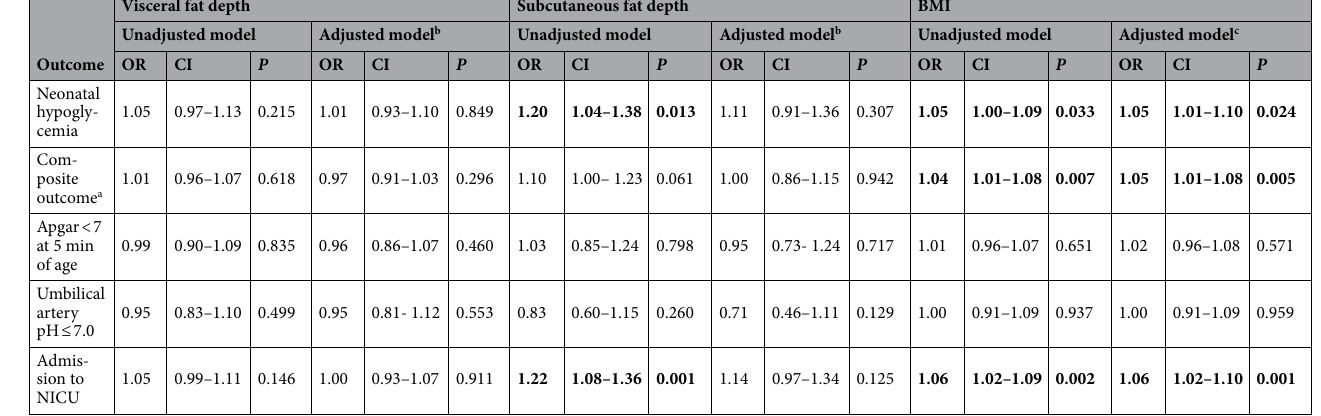
Table 4. Associations between early mid pregnancy visceral fat depth, subcutaneous fat depth, early pregnancy BMI, and outcomes. Data are odds ratios (OR) (95% confidence interval (CI)) for the change in outcome per 5 mm increase in fat depth and per unit increase in BMI (kg/m 2 ). Data were analyzed using logistic regression models. Significant results are in bold. NICU neonatal intensive care unit, BMI body mass index. a Apgar < 7 at 5 min of age, or umbilical artery pH ≤ 7.0, or admission to NICU. b Adjustments in the model: early pregnancy BMI, age, smoking at first antenatal visit, parity, and country of birth. c Adjustments in the model: age, smoking at first antenatal visit, parity, and country of